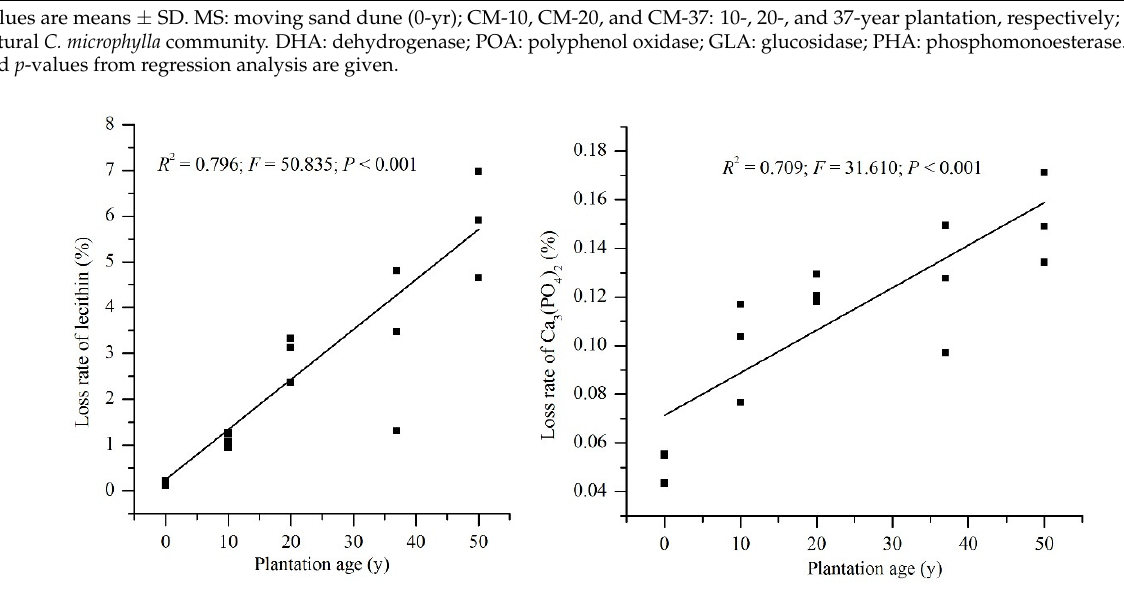
Table 2. Activities of soil enzyme at different Caragana microphylla plantations.